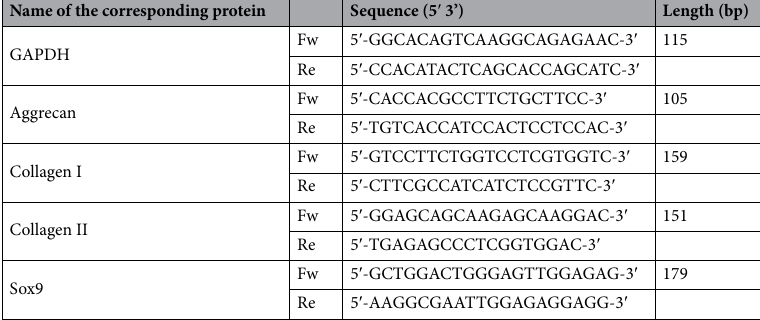
Table 2. Primers sequences used in Real-time PCR a . Fw forward, Re